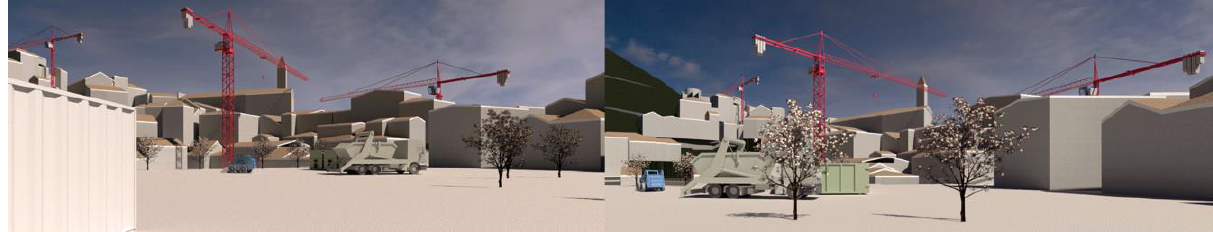
Figure 5. The digitization as a tool to control and support the construction site of minor historical centres, that were severely affected by the 2009 telluric